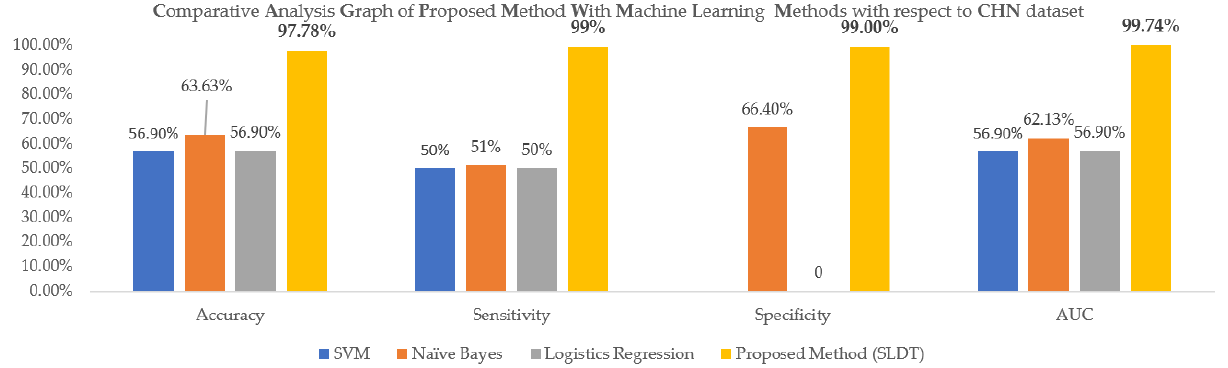
Figure 11. Comparative analysis graph of the proposed method with the machine learning methods with respect to the CHN dataset.